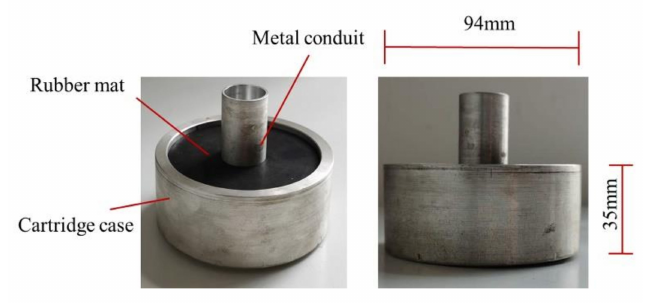
Figure 2. Projectile sabot.